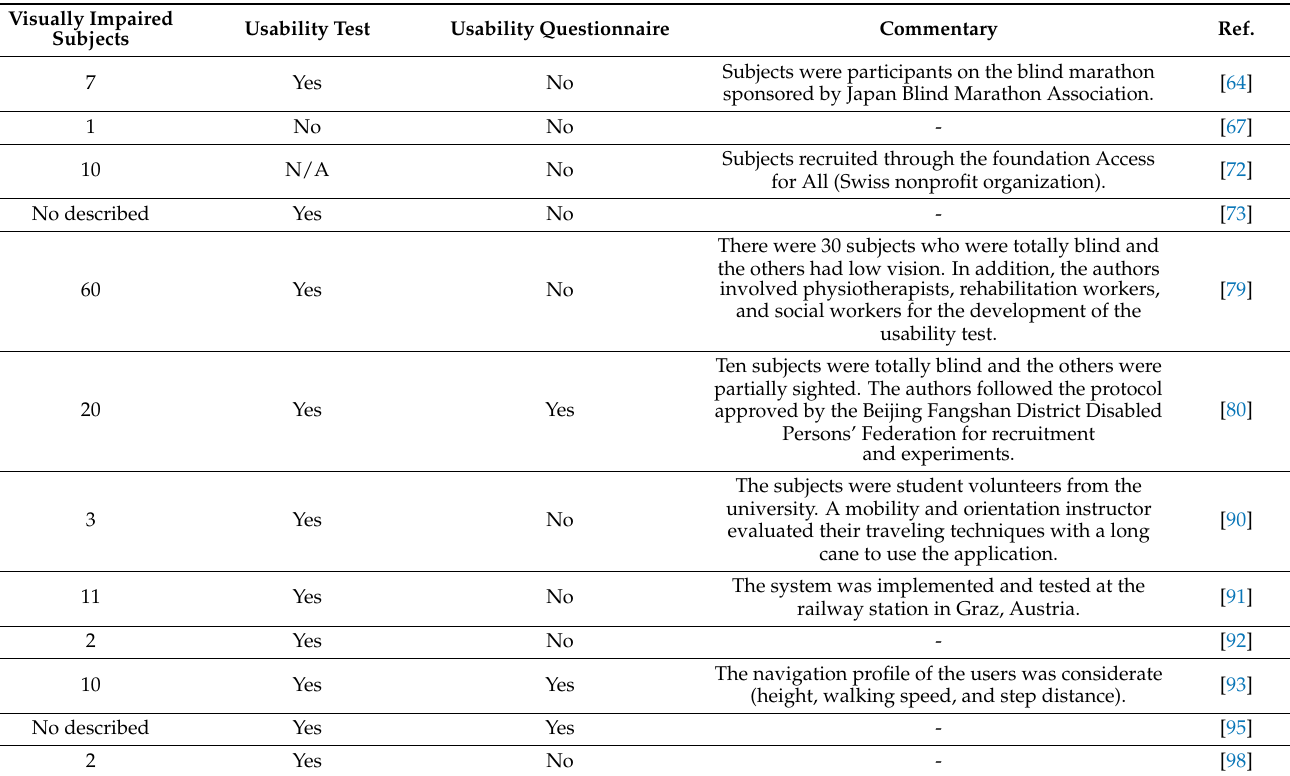
Table 5. Summary of the visually impaired participation and usability discussion. Visually Impaired